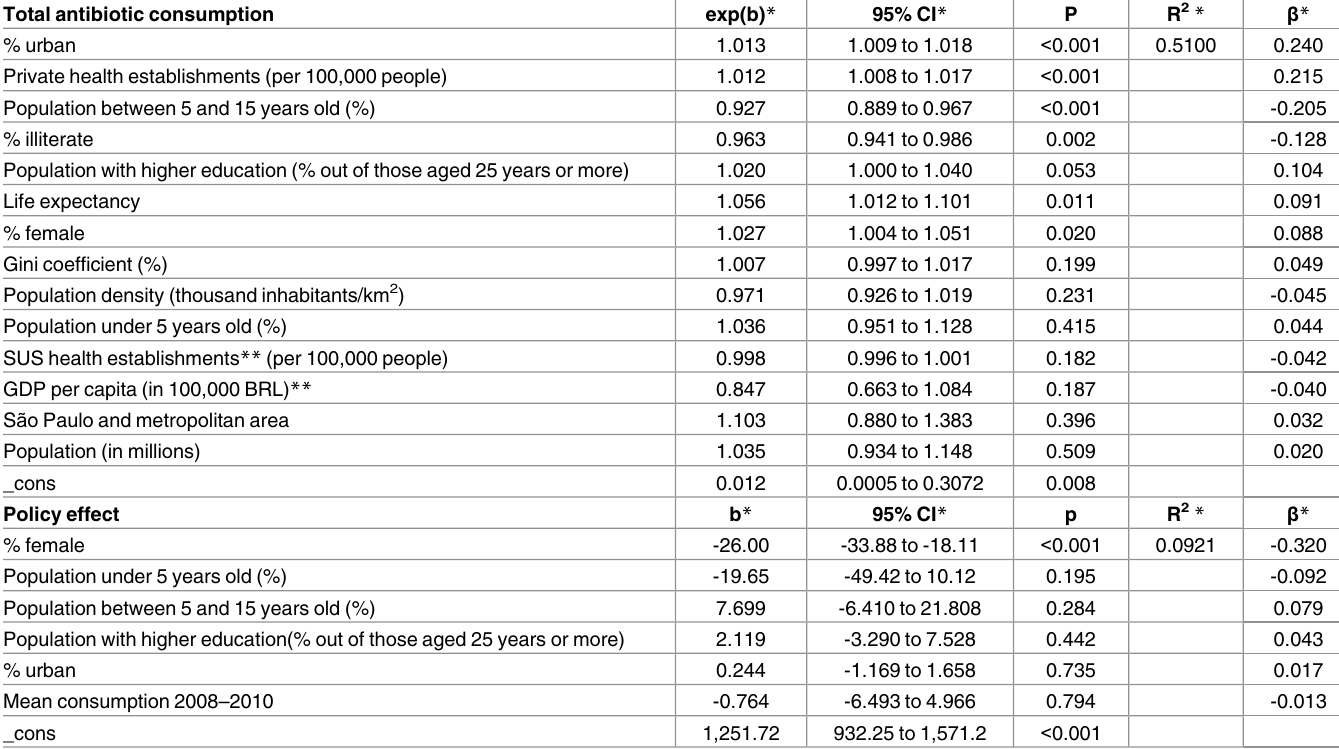
Table 3. Multivariable regression